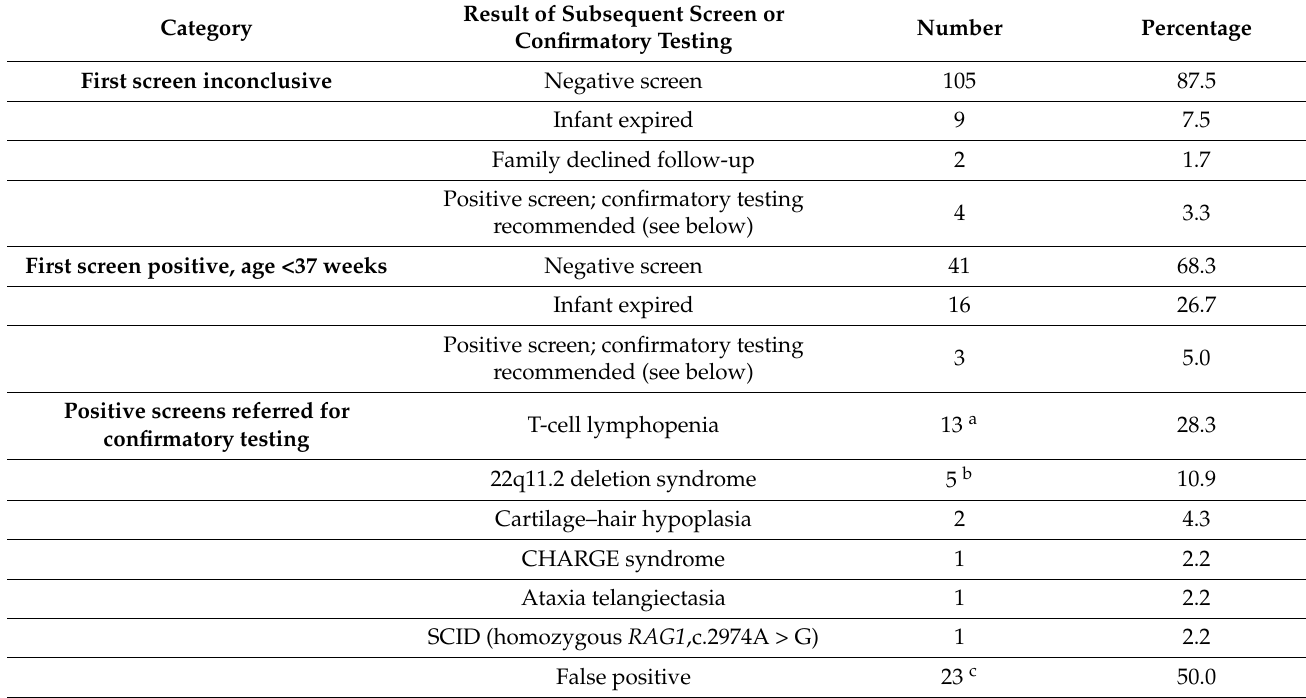
Table 4. Screening results for Wisconsin newborns with follow-up